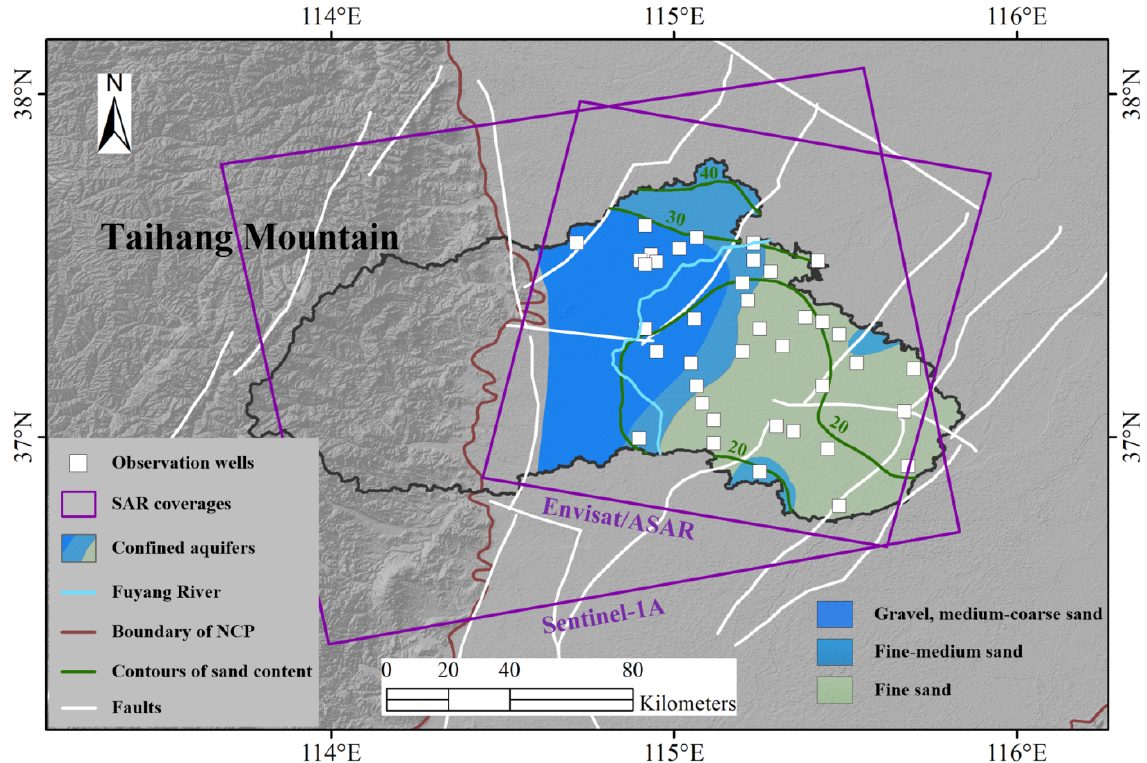
Figure 1. Map of study area in the NCP. The gray line highlights the extent of Xingtai. Observation wells are shown with white squares. The purple rectangles mark the coverage of Envisat/ASAR and Sentinel-1A SAR datasets. The blue line marks the Fuyang River. The brown line shows the boundary of the NCP. The green lines represent the contours of the sand content. The white lines represent the faults.